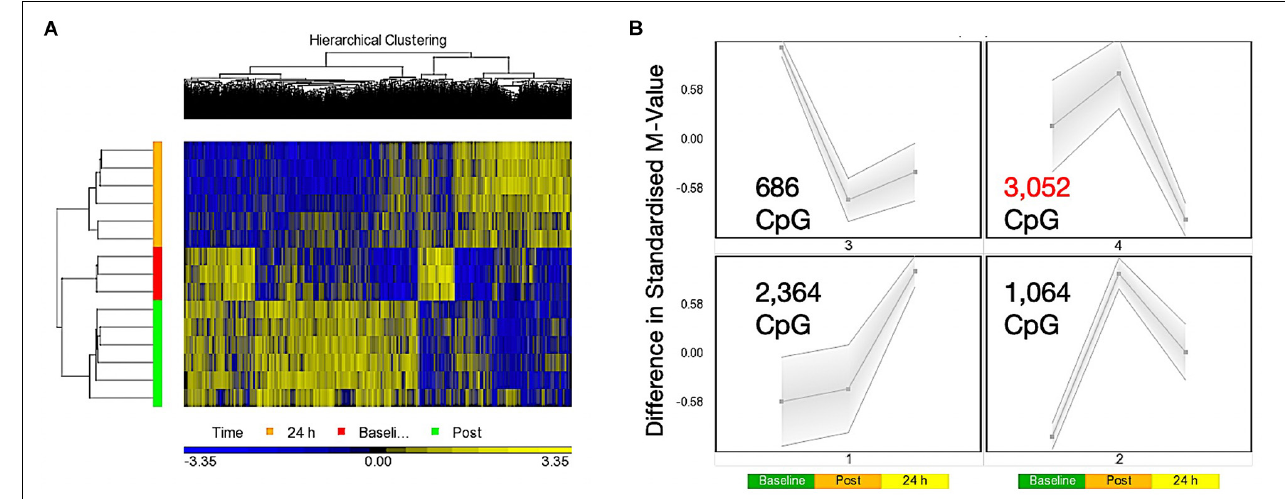
FIGURE 1 | (A) Hierarchical heat map for analysis of DMPs over exercise time in both trials combined (Red – Baseline, Post = 30 min post – Green, 24 h – Orange). (B) SOM temporal analysis of DMPs over exercise time in both trials. Post = 30 min post exercise.